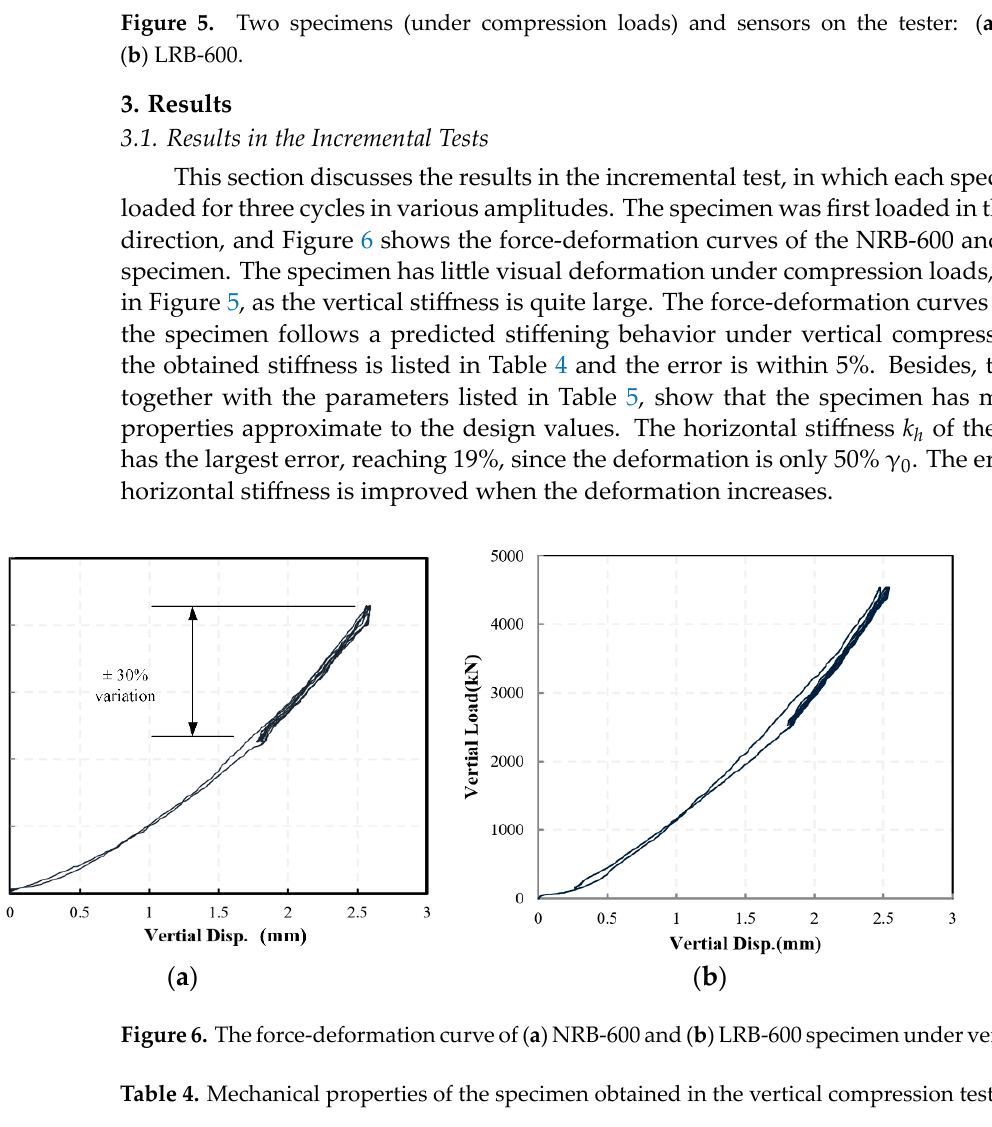
Figure 5. Two specimens (under compression loads) and sensors on the tester: ( a ) NRB ‐ 600; ( b ) LRB ‐ 600